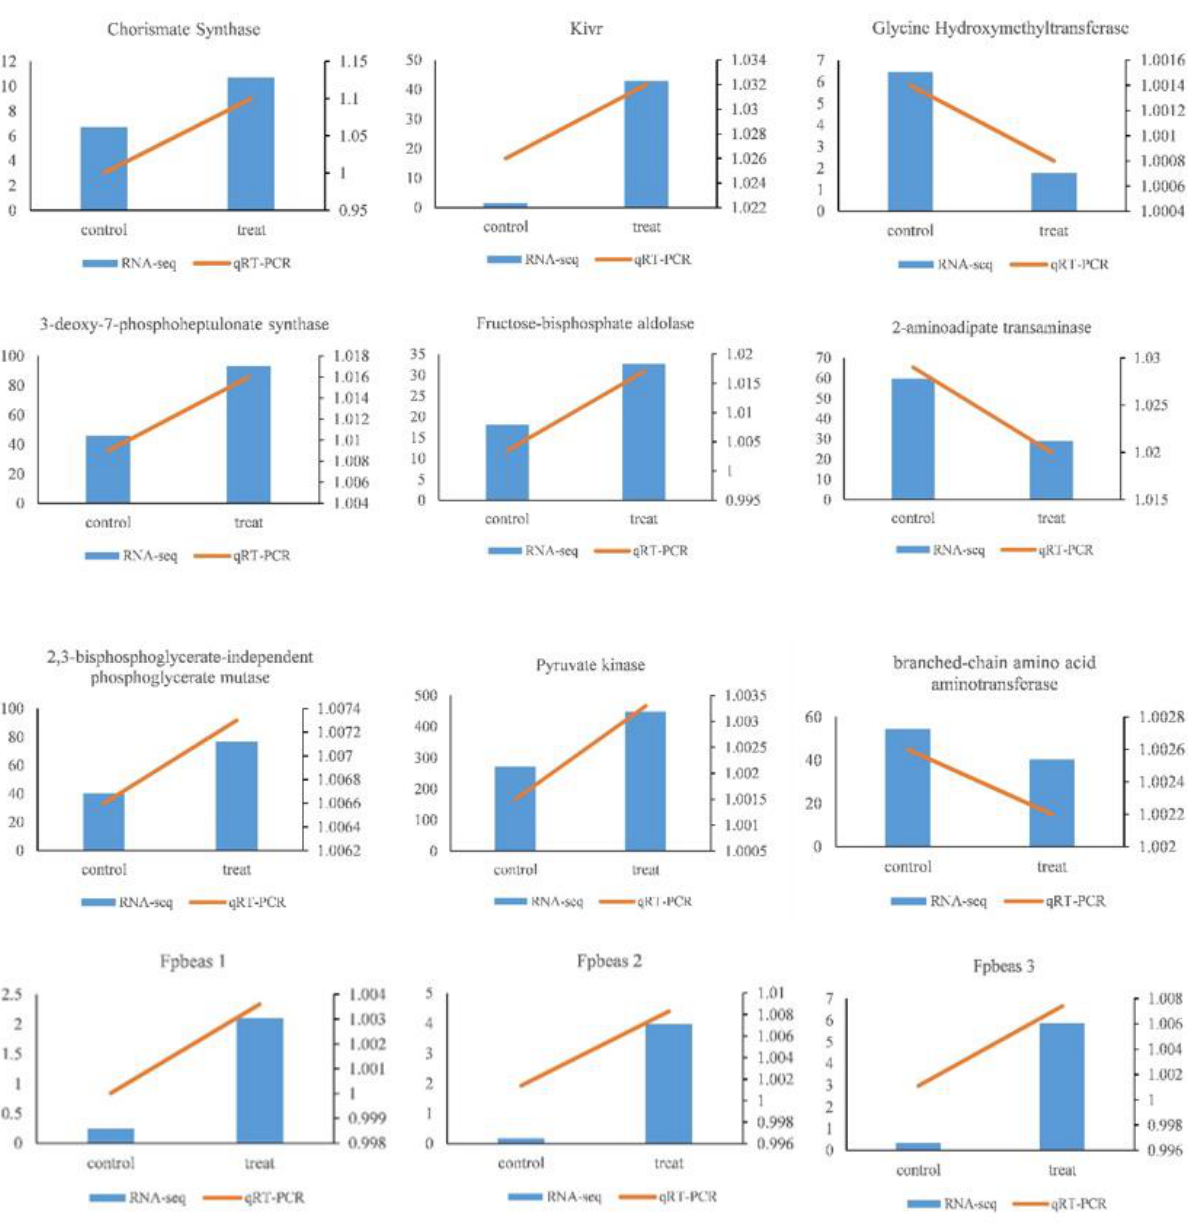
Figure 7. Quantitative real-time PCR. The qRT-PCR was carried out in biological triplicate. The blue bar indicates the relative expression of the genes in RNA-Seq data, and the yellow broken line indicates the relative expression of the genes in qRT-PCR data. The left ordinate represents the gene expression in RNA-Seq, and the right ordinate represents the gene expression in qRT-PCR.